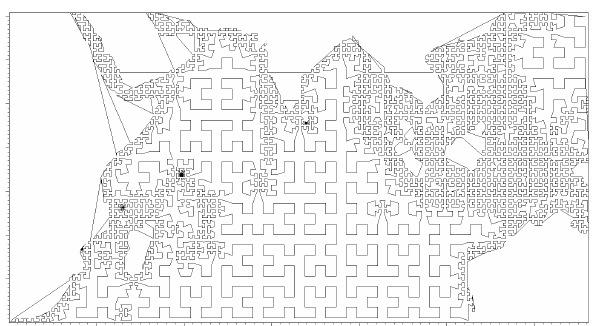
Figure 9. Hilbert space-filling curve for Indian Ocean domain with four